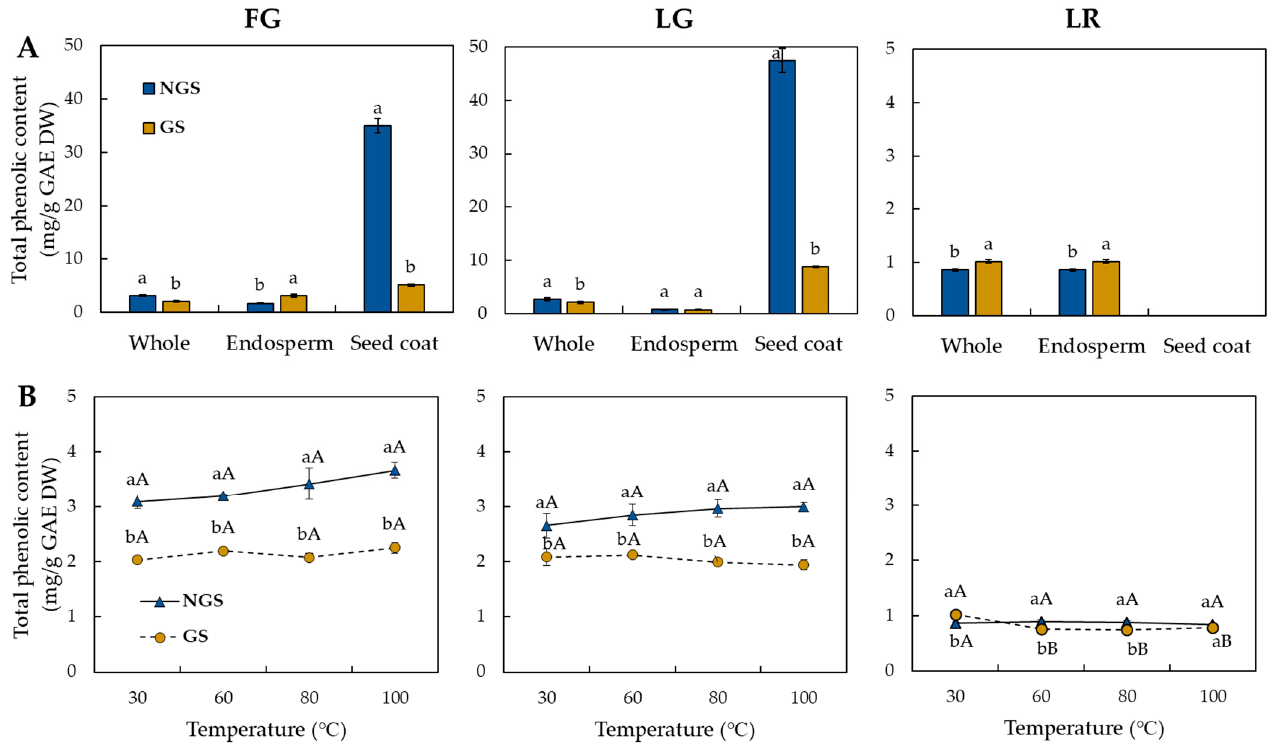
Figure 2. Changes in TPC of ( A ) different cultivars of lentil whole seeds, seed coat, and endosperm, ( B ) whole NGS and GS during different thermal treatment. Different lowercase letters indicate the significant differences (Tukey’s studentized test at p < 0.05) between NGS and GS, and capital letters indicates the significant differences (Tukey’s studentized test at p < 0.05) between lentil cultivars treated with different temperatures.